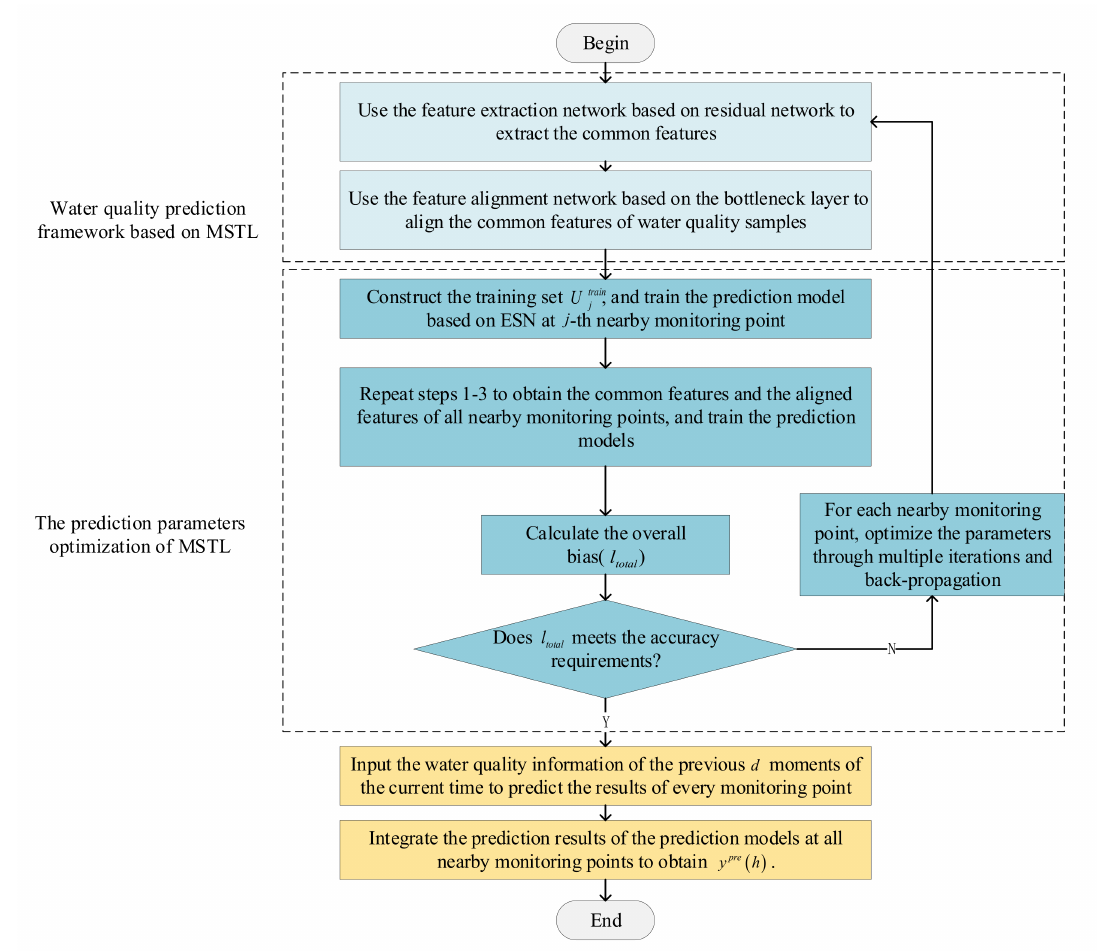
Figure 5. Overall process of water quality prediction method based on